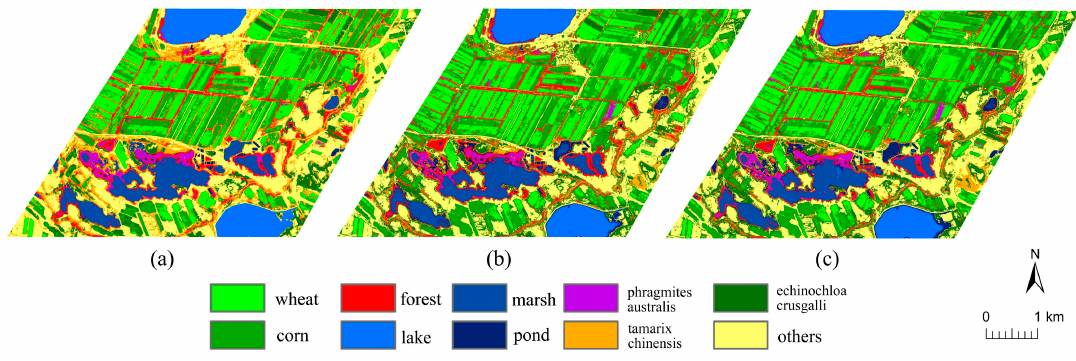
Figure 4. The classification results of the RFC ( a ); SVM ( b ); and ANN ( c ) models. Table 3. The User’s and Producer’s accuracy of the RF classification (%).